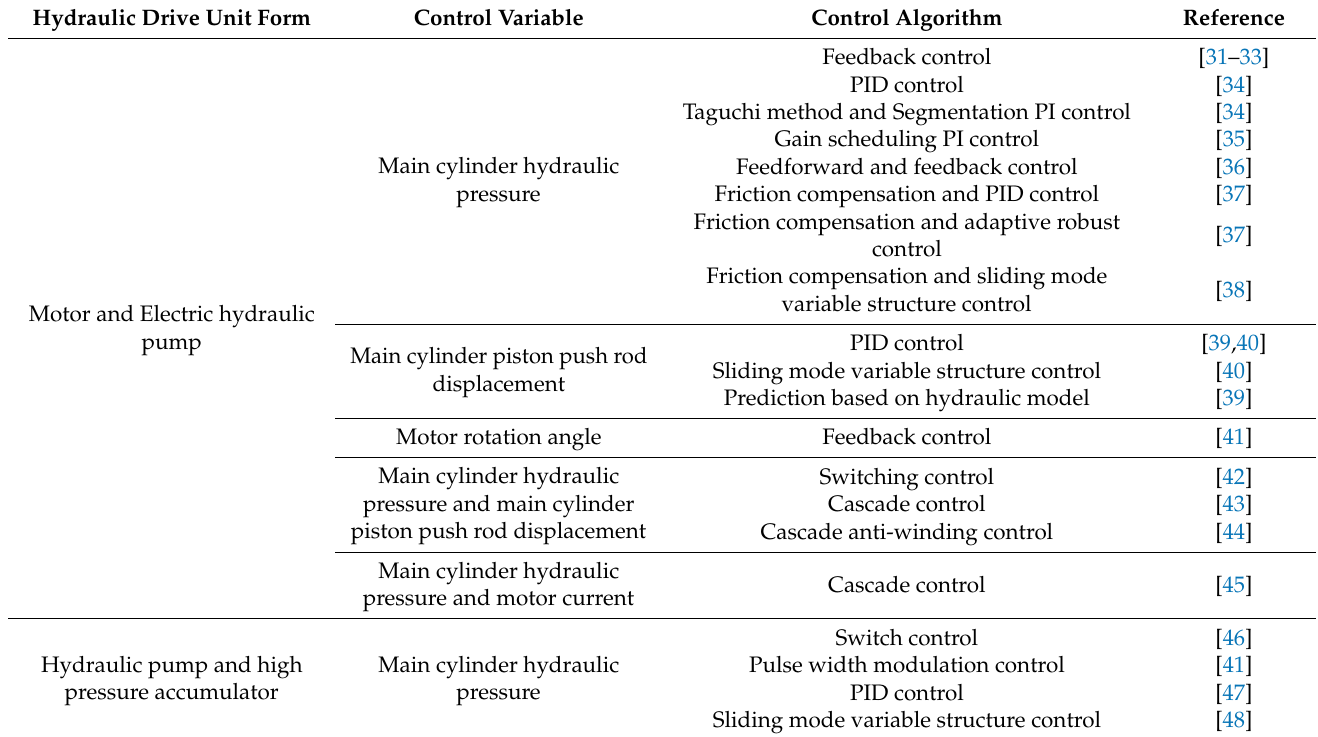
Table 1. Hydraulic pressure-control scheme of master cylinder of electro-hydraulic braking